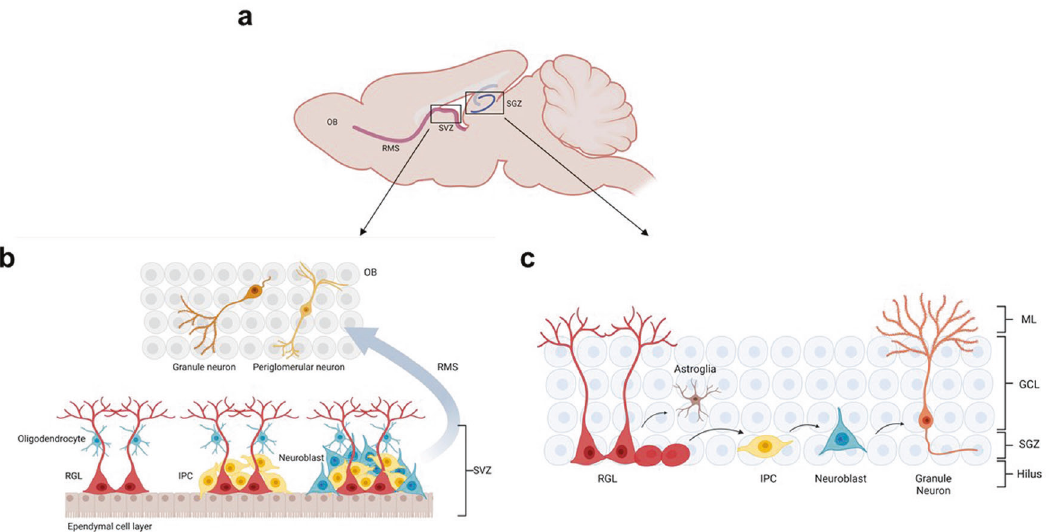
Fig. 2 Adult neurogenesis. a Adult neurogenesis in the olfactory bulb (SVZ) and hippocampus (SGZ). b The process of adult neurogenesis in the olfactory bulb requires a series of steps. RGL activation can generate IPCs that proliferate and differentiate into neuroblast. Some of neuroblasts migrate through the rostal migratory stream (RMS) and become mature and integrate into mature granule or periglomerular neurons in the olfactory bulb (OB). c The SGZ niche is composed of RGL, IPC, neuroblast, and granule neuron. Adult neurogenesis in the SGZ undergoes a process similar to that in the SVZ. ML molecular layer, GCL granule cell